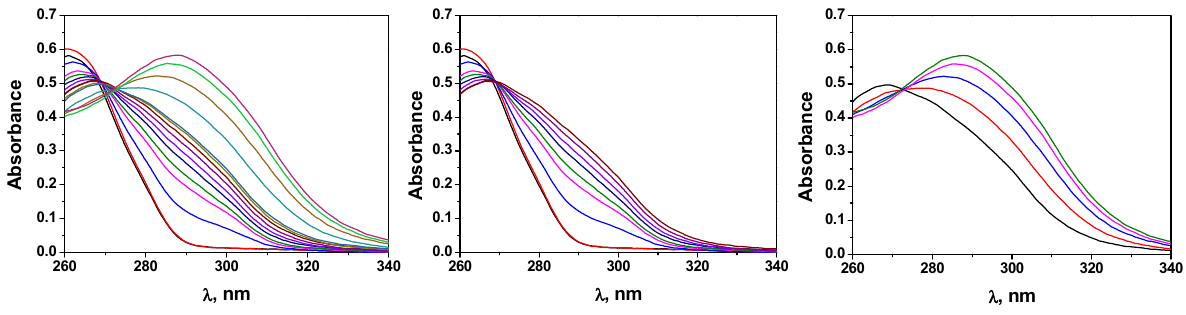
Figure 6. UV/Vis spectra corresponding to the interaction studies of CoA with Hg(II) (left). The figures in the middle and on the right are spectra corresponding to the complexation of the first and second Hg(II) molecules to each sensory molecule ( 3 ), respectively. Two isosbestic points can be clearly